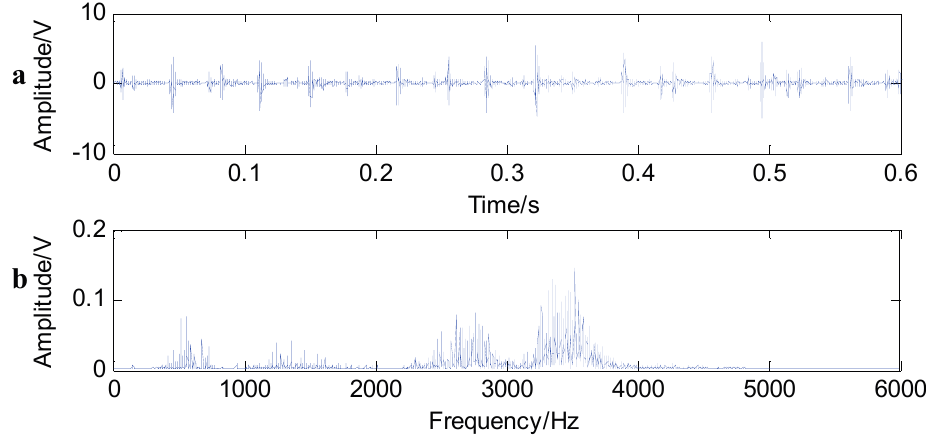
Figure 11. Time waveform of the original signal with an outer race defect ( a ); and the spectrum of the original signal ( b ).